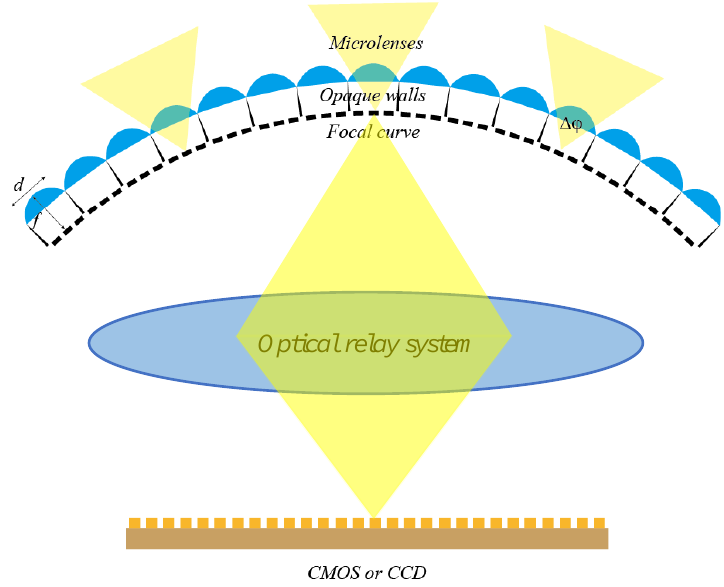
Figure 7. Surface compound eye imaging scheme based on relay imaging system.